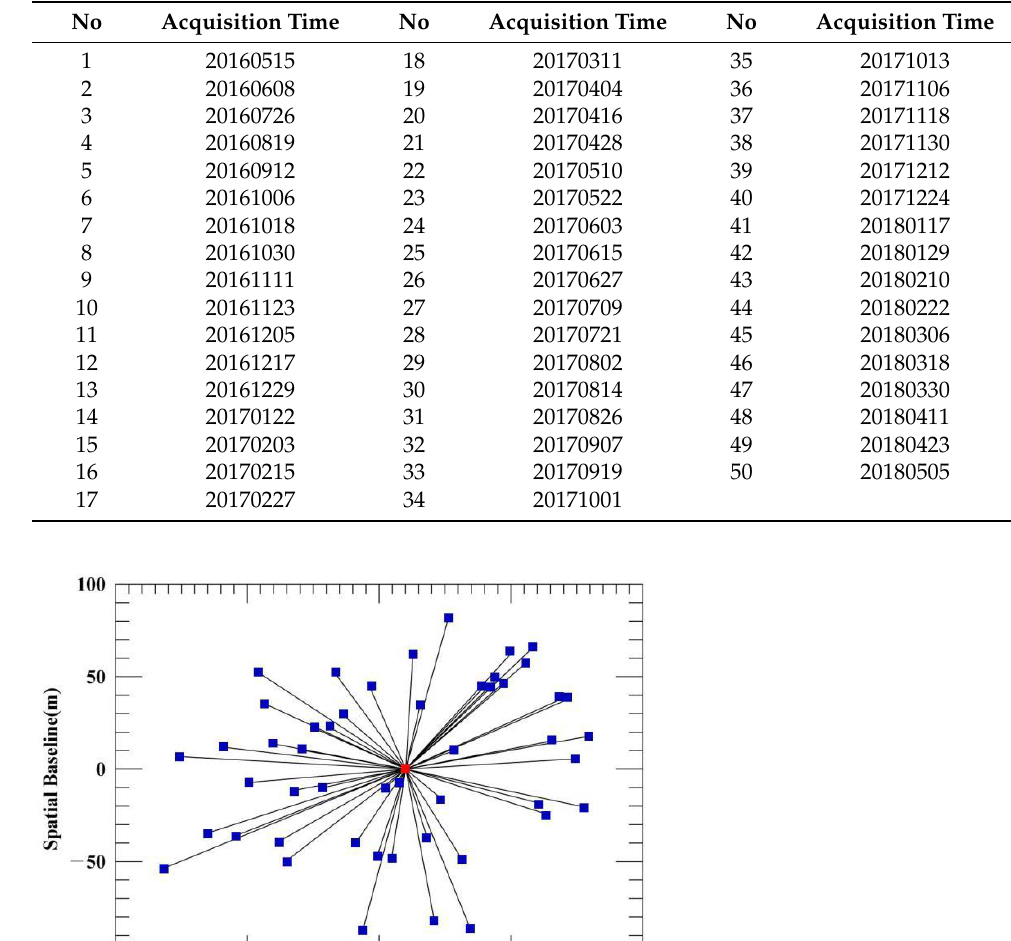
Table 2. The List of SAR data and acquisition times.